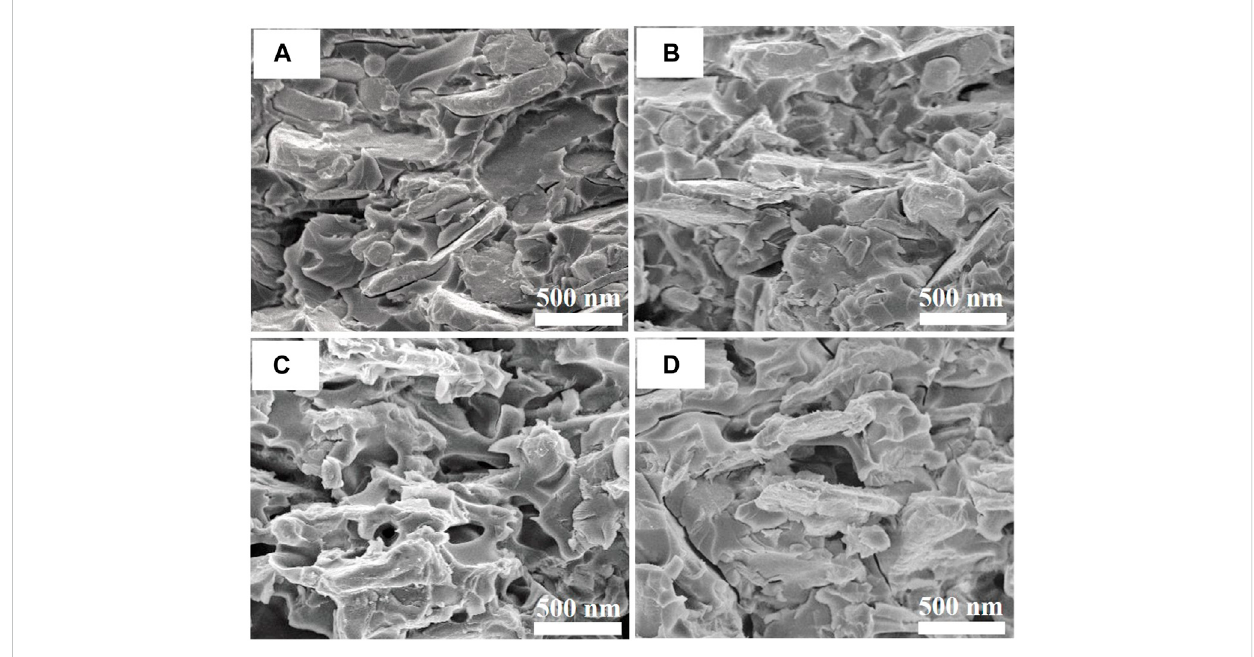
FIGURE 5 SEMimagesforfracturesurfaceofFeCoCr/siliconeresincoatingsafteradhesiontestforsamplesheattreatedat400 ° Cfordifferenttime: (A) 0 h, (B) 1 h, (C) 5 h and (D) 10 h.